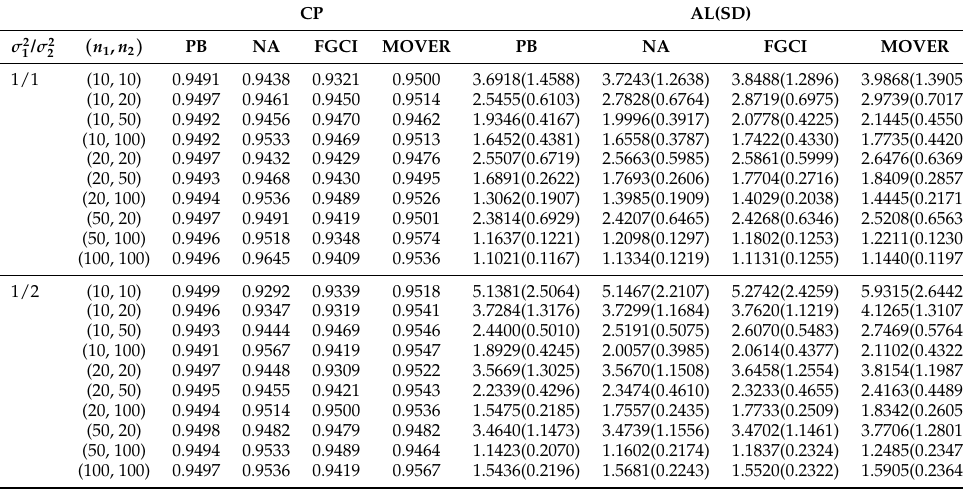
Table 2. CP and AL of 95% confidence intervals for η under µ 1 = 0 and µ 2 =